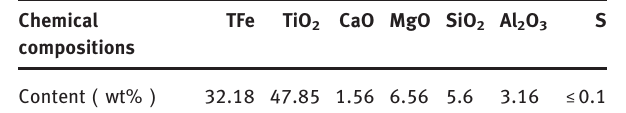
Table 1: Chemical composition of the ilmenite concentrate